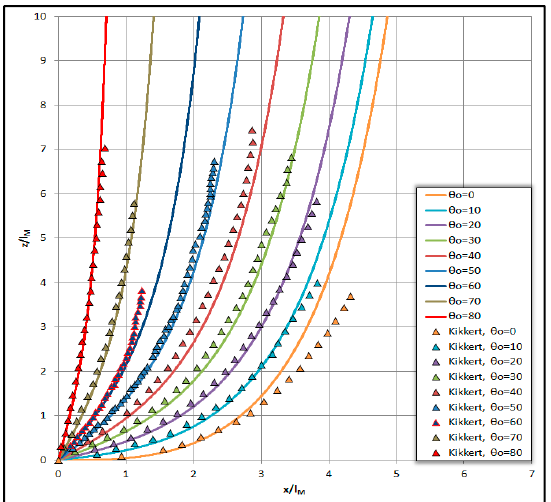
Figure 1. Comparison between model and experimental results regarding the trajectory of positively buoyant saline